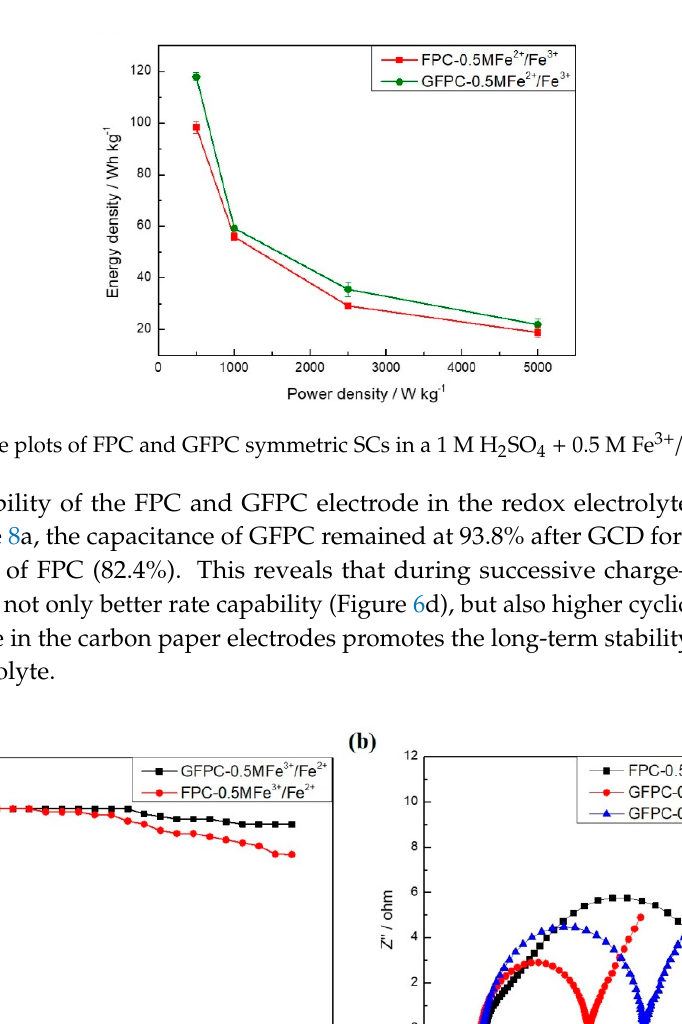
( b ) Nyquist plots of symmetric FPC and GFPC supercapacitors in 1 M H 2 SO 4 + 0.5 M Fe 3+ /Fe 2+ electrolytes,